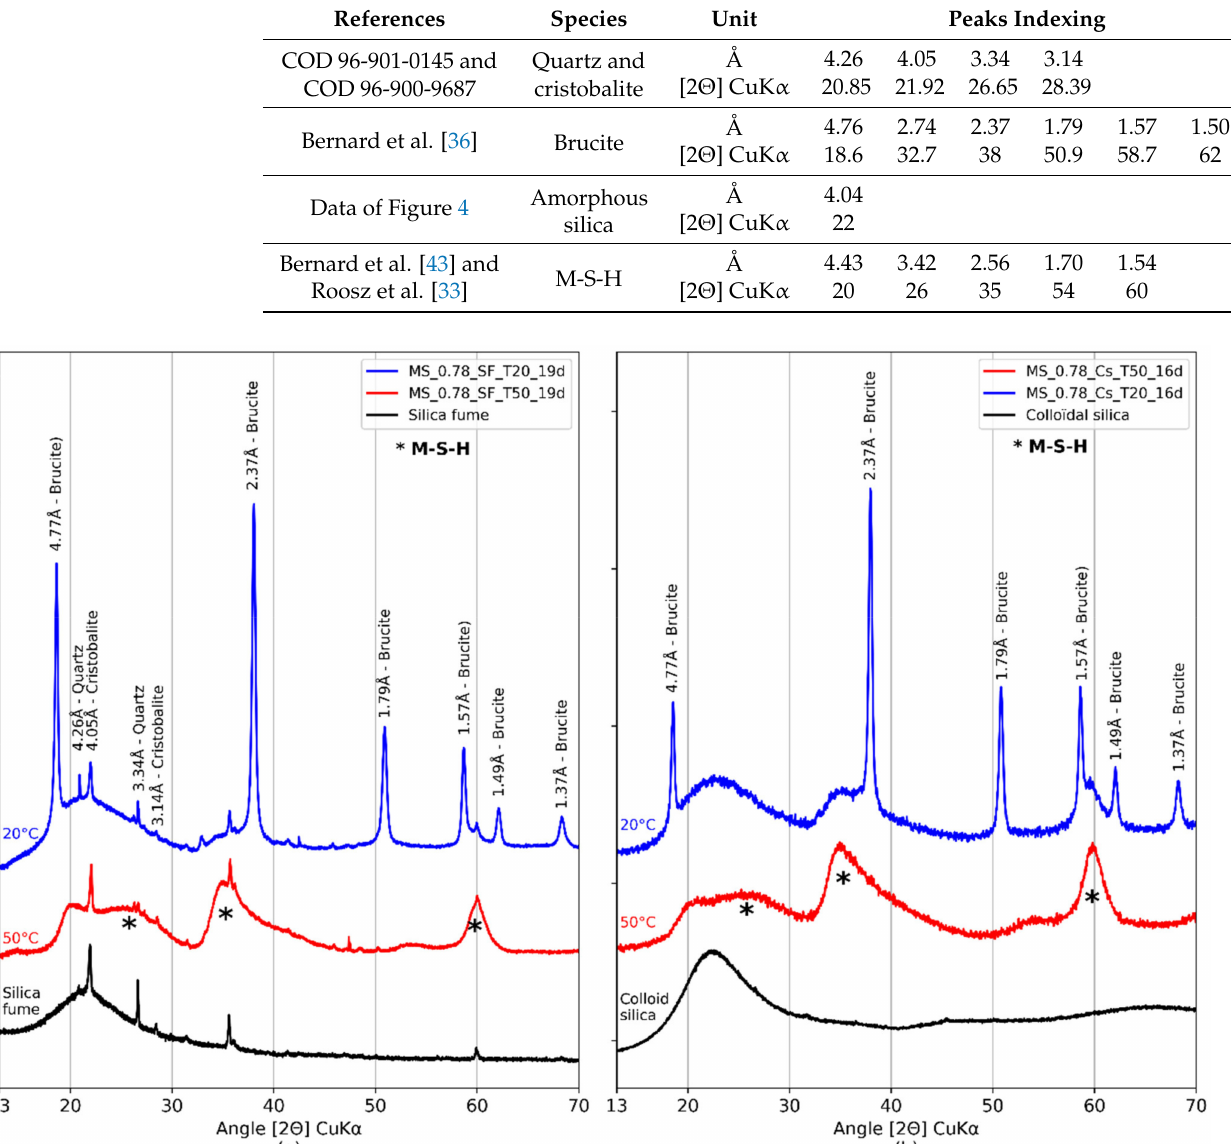
Table 3. Indexing of X-ray peaks for quartz, cristobalite, brucite, amorphous silica, and M-S-H.